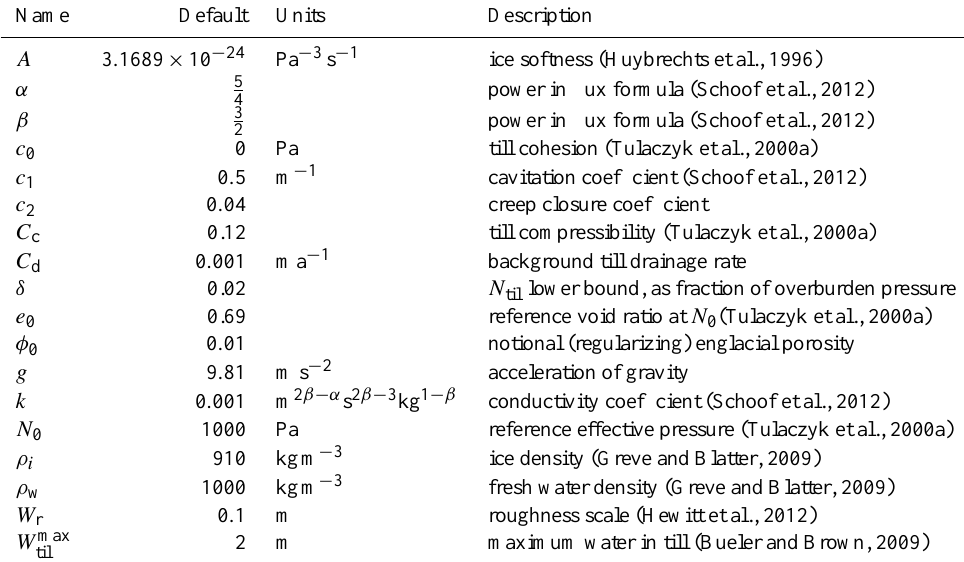
Table 1. Physical constants and model parameters. All values are configurable in PISM; see Table 3. Name